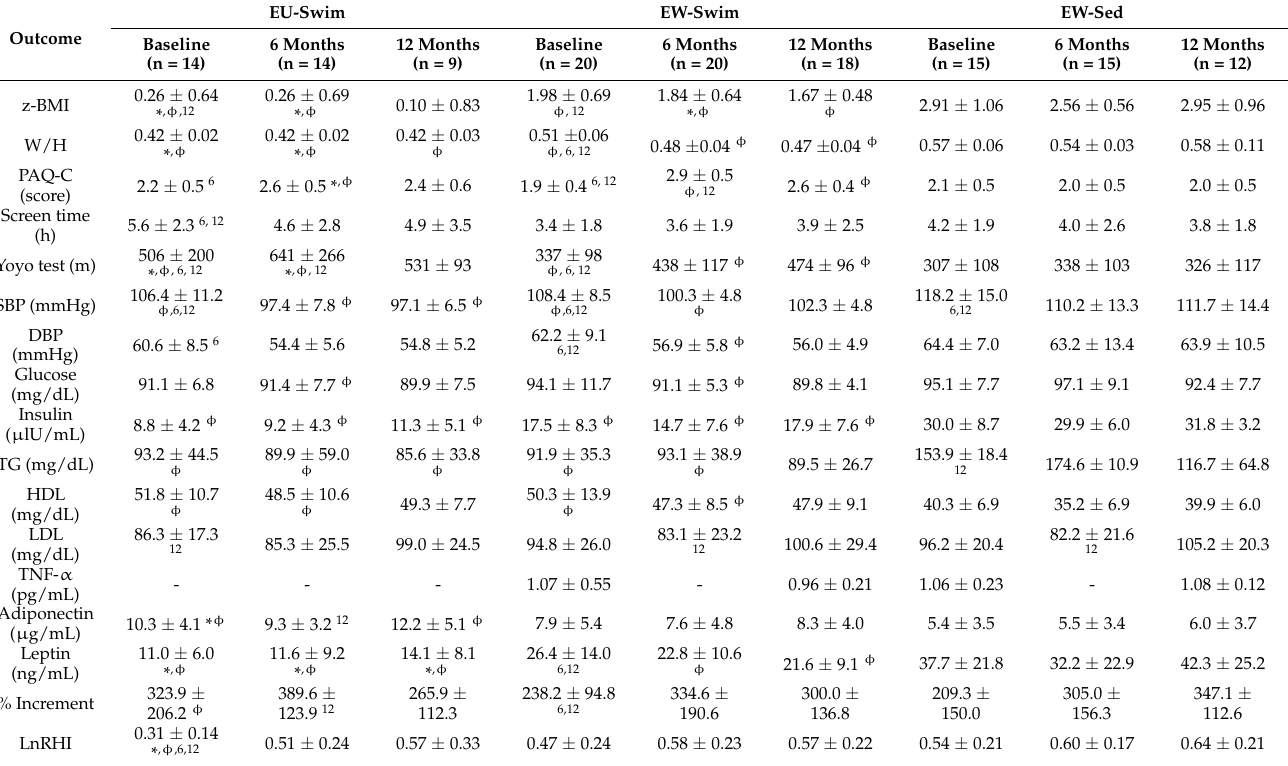
Table 2. Data of anthropometry, physical activity level, screen time, cardiorespiratory fitness, blood pressure, biochemical markers, endothelial function, autonomic modulation, and ultrasound out- comes in ‘eutrophic swimming’ (EU-Swim), ‘excess weight swimming’ (EW-Swim), and ‘excess weight sedentary’ (EW-Sed) groups at baseline and after 6 and 12 months of